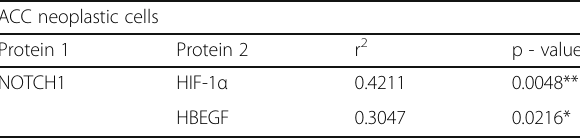
Table 5 Linear regression showed association among NOTCH1 and HIF-1 α and HBEGF of labelling area of proteins in neoplastic cells of